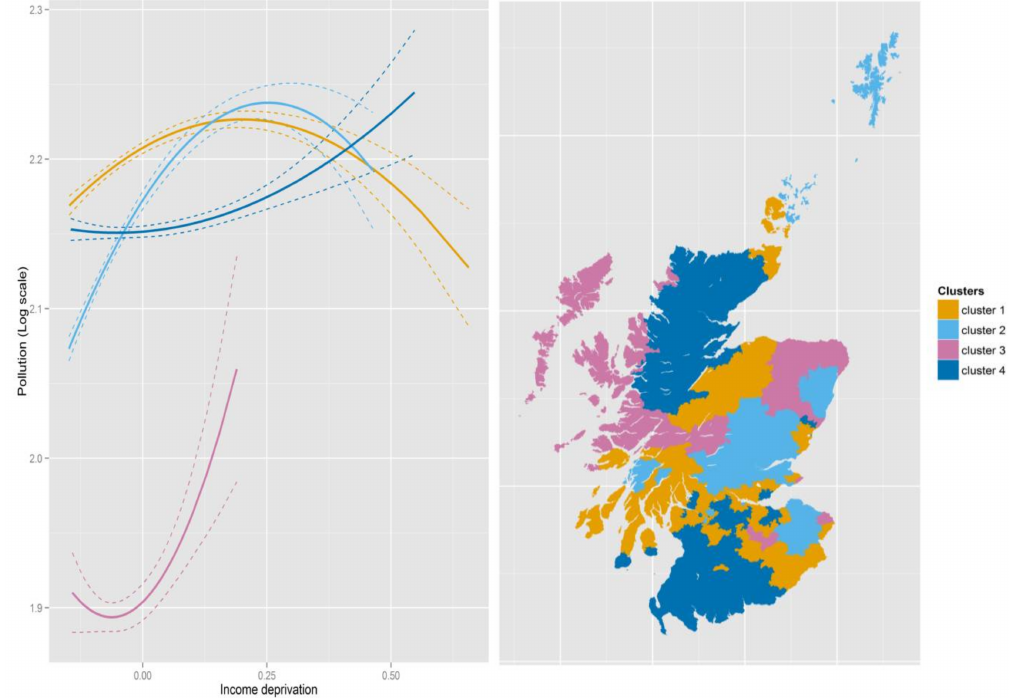
Figure 5. Pollution–deprivation relationships for the clusters in 2004. Note: The dashed lines are the approximate 95% confidence intervals.